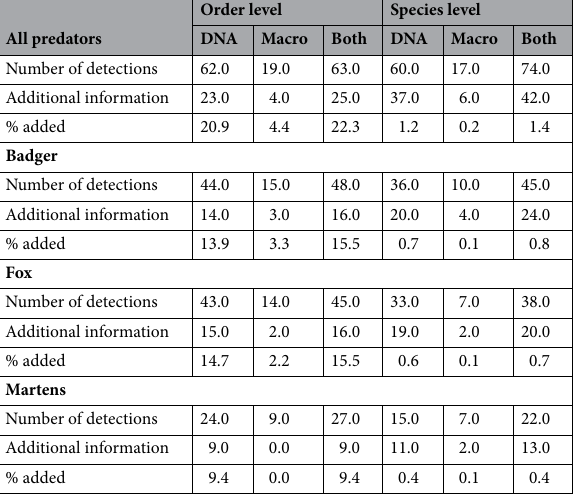
Table 1. Overview of number of detections at the order and species level, using eDNA metabarcoding (eDNA) and macroscopic diet analysis (Macro), depicted as each method individually or pooled (Both). Additional detections and the percentage (%) added to order or species information relative to field observations are